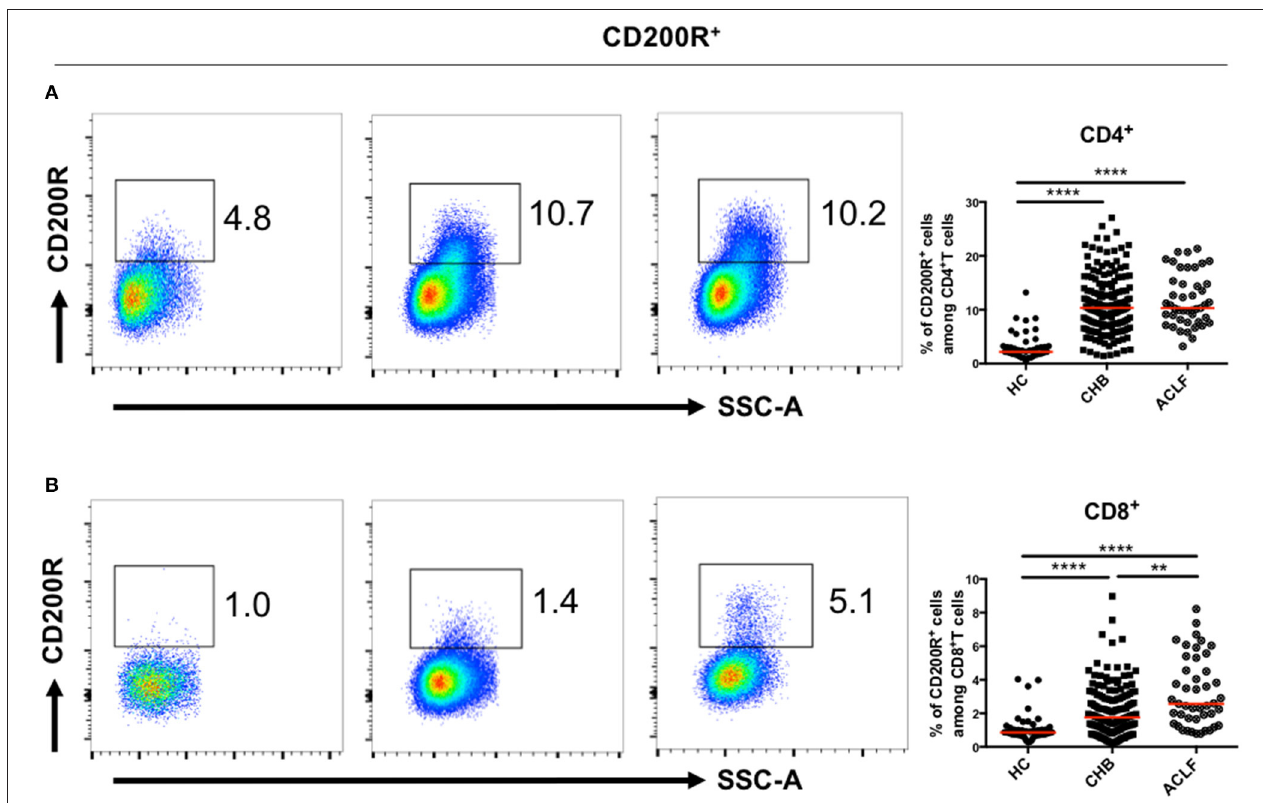
FIGURE 2 | CD200R + T cells in patients with ACLF and CHB. Representative dot plots of CD200R + CD4 + (A) and CD200R + CD8 + (B) T cell frequency for each group. A Kruskal–Wallis test was used to analyze statistical differences. ** p < 0.01, **** p < 0.0001.